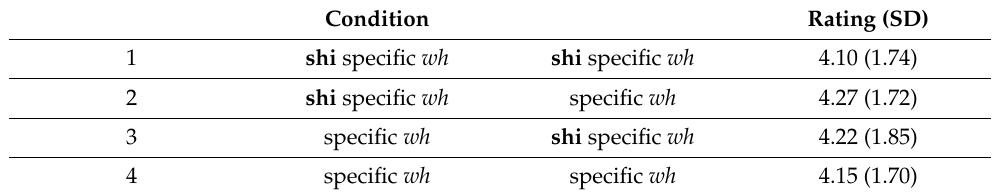
Table 7. Mean acceptability ratings in sub-experiment 2.